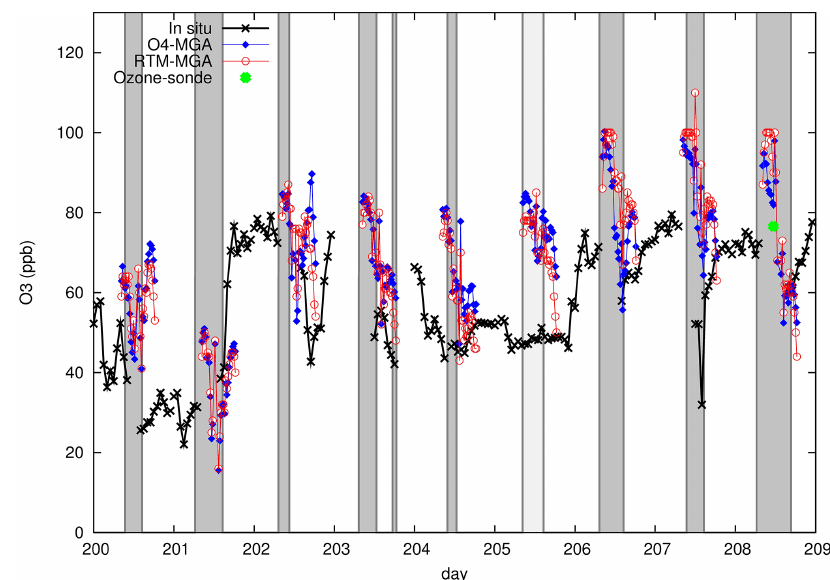
Figure 9. Surface O 3 mixing ratios (in ppbv) at the Izaña observatory. The red open circles correspond to the ozone mixing ratios obtained using single-scattering RTM-MGA. The blue diamonds correspond to O 3 mixing ratios obtained using O 4 -MGA. The black crosses corre- spond to the in situ measurements. The green point corresponds to the O 3 concentration at the altitude of the station as obtained from the ozone-sounding. Dark grey regions correspond to those periods in which NO 2 in situ measurements are above the detection limit of the in situ instrument. Light grey indicates an increase in the in situ NO 2 measurements on day 205, below the detection